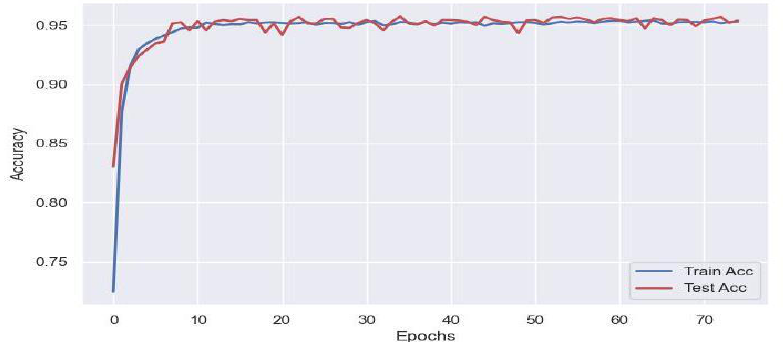
Figure 13. Accuracy of the neural network.